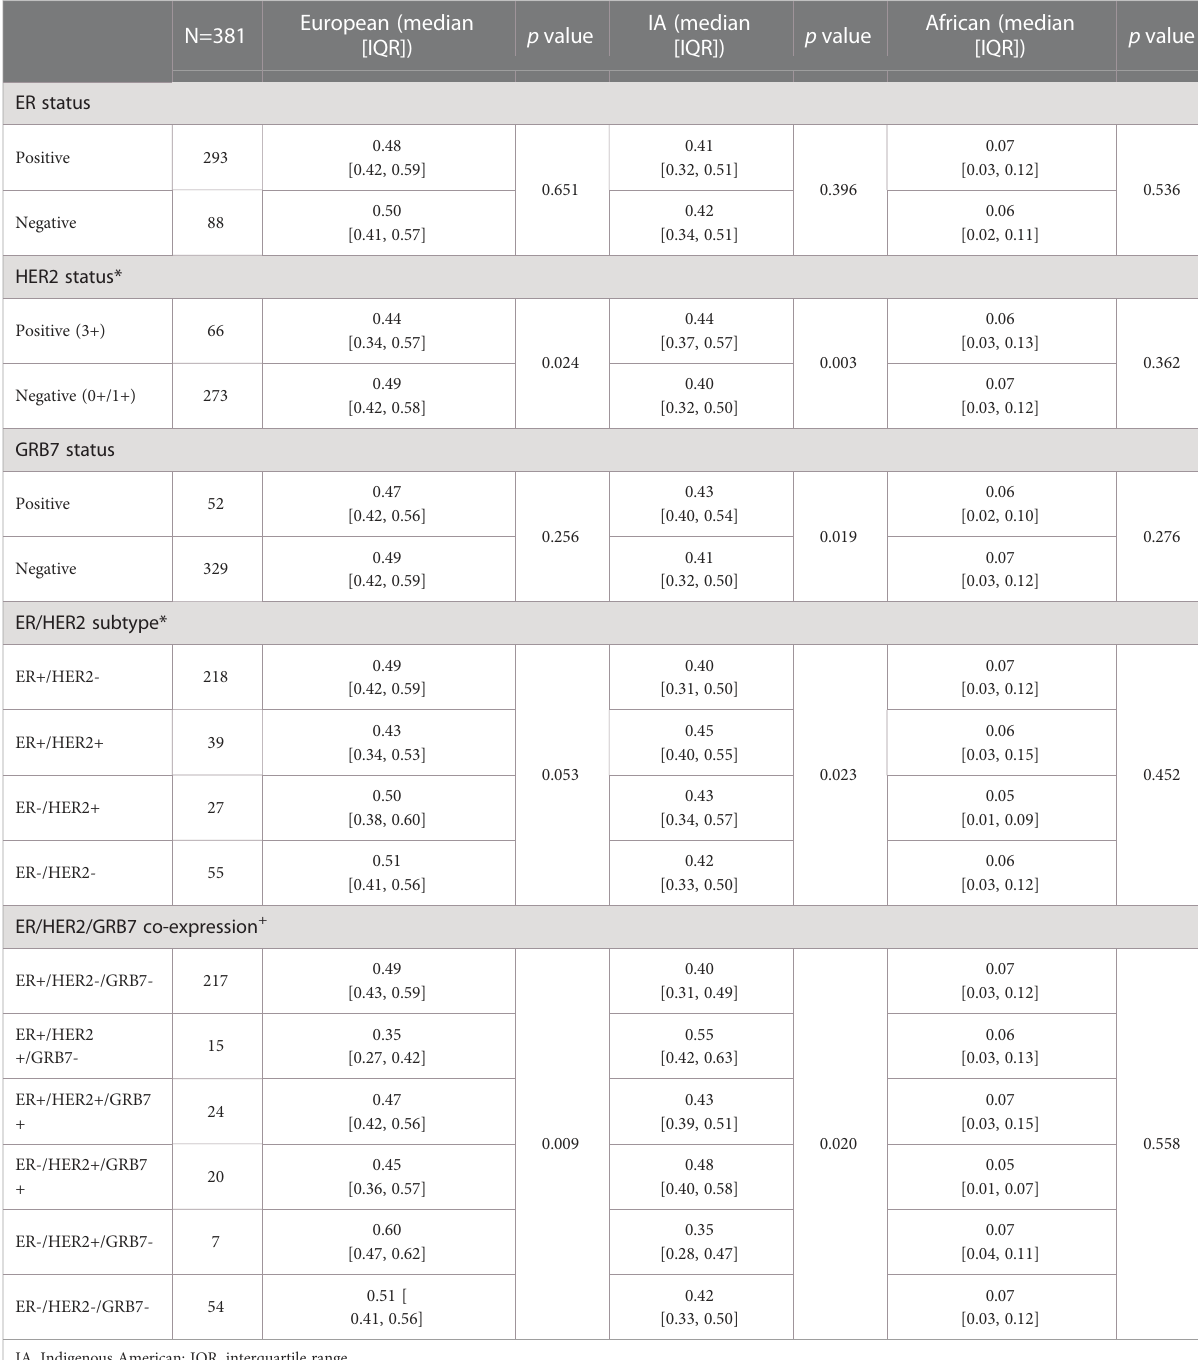
TABLE 2 Differences of genetic ancestry fractions according to the status of ER, HER2 and GRB7, and their